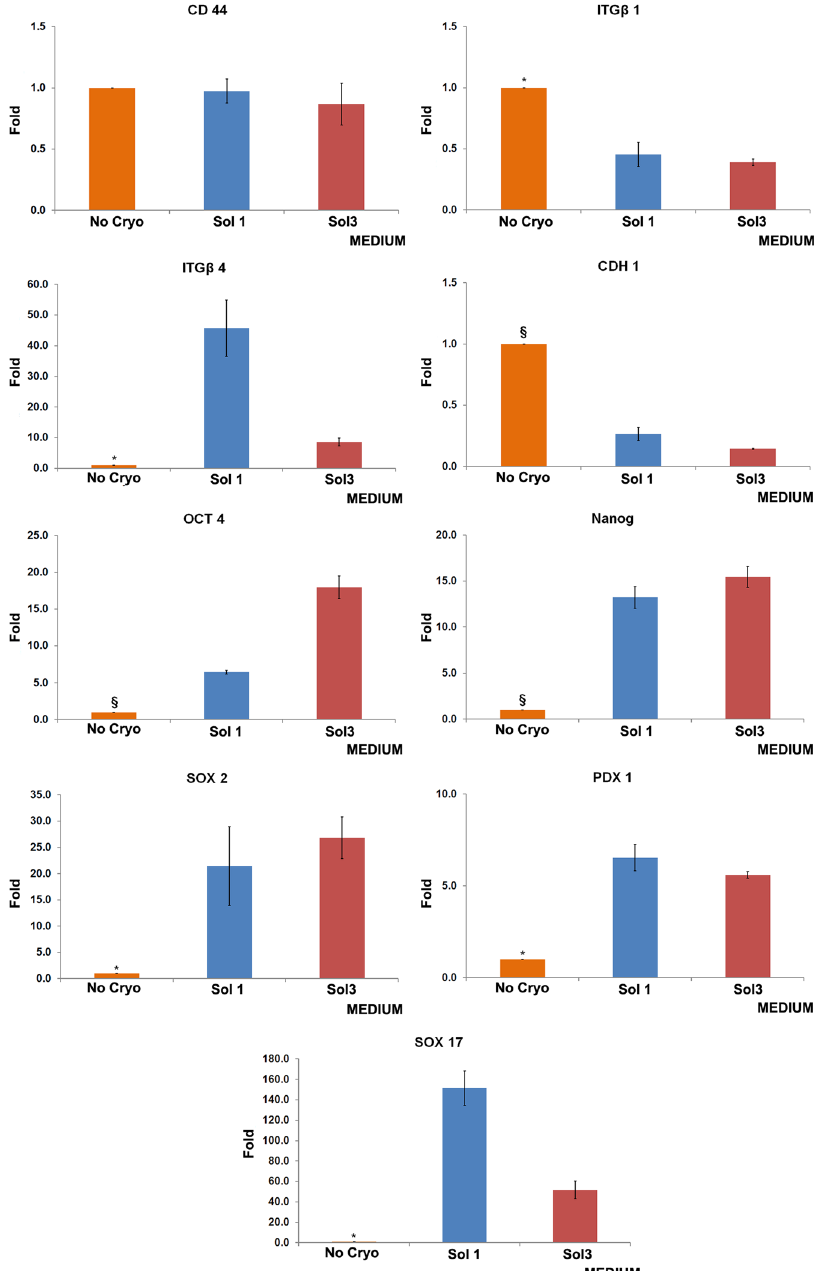
Figure 2. Expression of pluripotency and molecule adhesion genes in cultures from cryopreserved cells in solution 1 (Sol1), Sol3, or freshly isolated, that is not cryopreserved (No Cryo) human biliary tree stem cells (hBTSCs). Relative gene expression of SOX2. Cryopreserved hBTSCs in both Sol1 and 3 showed increased expression. Data are expressed as mean ± standard error (SE) of 9 experiments; * p < 0.05. Relative gene expression of PDX1. Cryopreserved hBTSCs in both Sol1 and 3 showed increased expression. Data are expressed as mean ± SE of 9 experiments; * p < 0.05. Relative gene expression of NANOG. Cryopreserved hBTSCs in both Sol1 and 3 showed increased expression. Data are expressed as mean ± SE of 9 experiments; § p < 0.01. Relative gene expression of SOX17. Cryopreserved hBTSCs in both Sol1 and 3 showed increased expression. Data are expressed as mean ± SE of 9 experiments; * p < 0.05. Relative gene expression of OCT4. Cryopreserved hBTSCs in both Sol1 and 3 showed increased expression. Data are expressed as mean ± SE of 9 experiments; § p < 0.01. Relative gene expression of CD44. Data are expressed as mean ± standard error (SE) of 6 experiments. Relative gene expression of ITG β 1. Cryopreserved hBTSCs in both Sol1 and 3 showed reduced expression. Data are expressed as mean ± SE of6 experiments; * p < 0.05. Relative gene expression of ITG β 4. Cryopreserved hBTSCs in both Sol1 and 3 showed increased expression. Data are expressed as mean ± SE of 6 experiments; * p < 0.05 No Cryo vs others. Relative gene expression of CDH1. Cryopreserved hBTSCs in both Sol1 and 3 showed reduced expression. Data are expressed as mean ± SE of 6 experiments; § p <